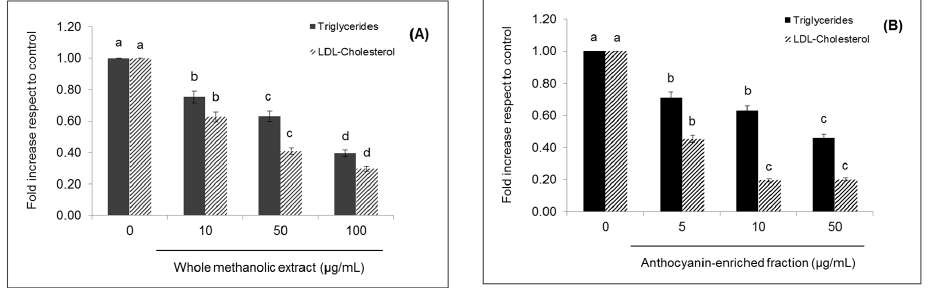
Figure 2. Effects of strawberry whole methanolic extract ( A ) and the anthocyanin-enriched fraction ( B ) on triglycerides and LDL-cholesterol content in HepG2 cells. Cells were treated with the indicated concentration of strawberry extracts for 24 h. The concentration of 0 µg/mL corresponds to the control (untreated cells). Values are expressed as the mean ± SD ( n = 3) of three independent experiments. Columns belonging to the same set of data with different superscript letters are significantly different ( p < 0.05).